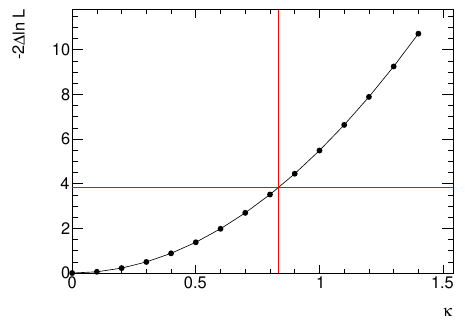
Figure 11 . The − 2∆ ln L as a function of κ for a 100 GeV LQ. The red lines indicate the interval at 95% confidence